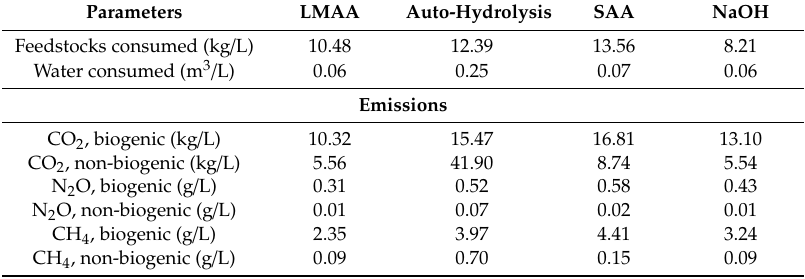
Feedstocks consumed, water consumed, and emissions from di ff erent pretreatment models